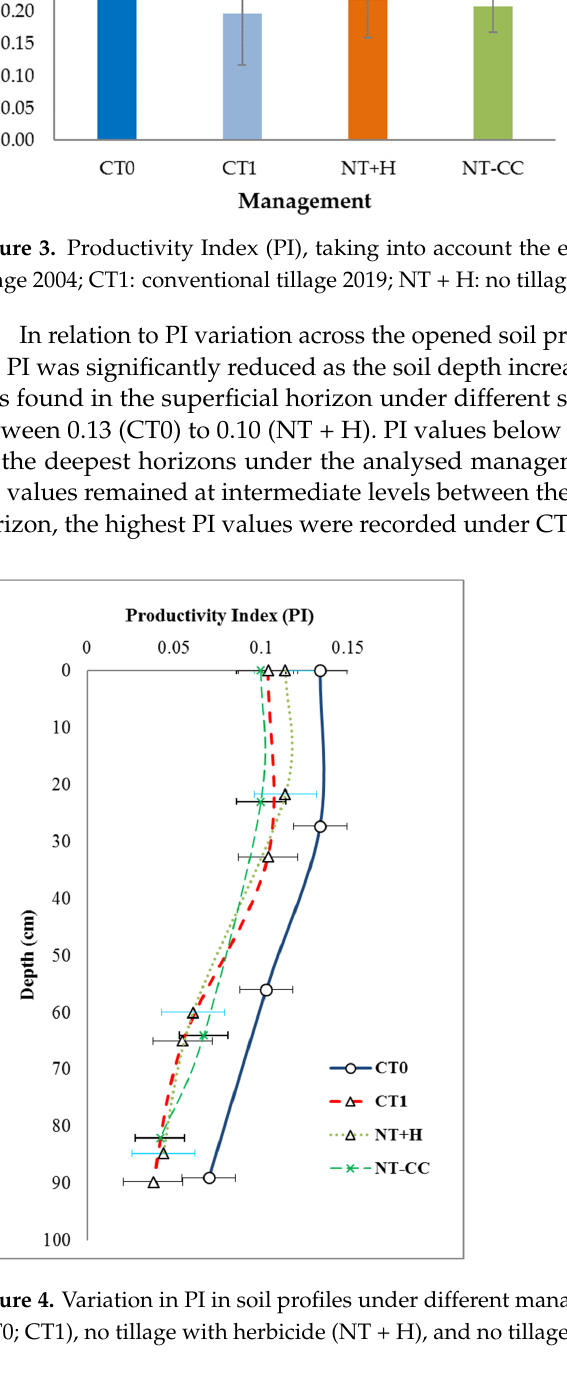
Figure 4. Variation in PI in soil profiles under different management systems. Conventional tillage (CT0; CT1), no tillage with herbicide (NT + H), and no tillage with cover (NT-CC).